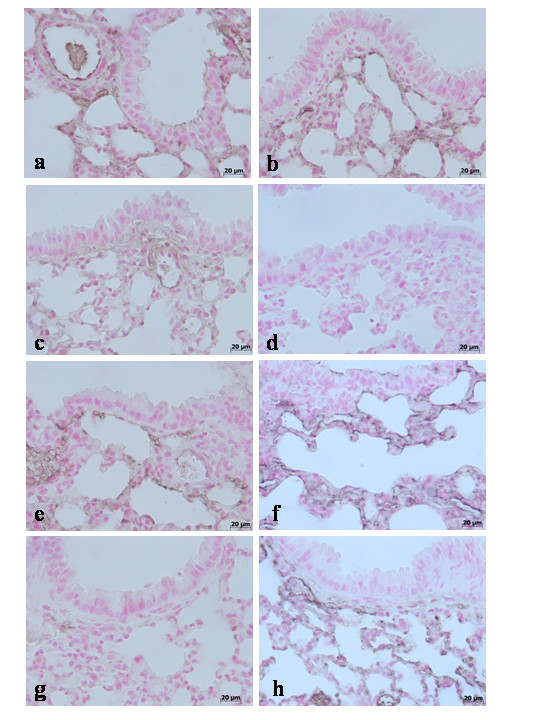
Immunohistochemical localization of Claudin-2 in the lung. In lung tissue sections collected at 24 hours from sham WT mice (a) and from sham TNF-αR1KO mice (b), Claudin-2 were uniformly and continuously distributed along the alveolar epithelium and the vascular endothelium. On the contrary, a significant disruption of immunohistochemical localization signal for Claudin-2 was observed in the lung tissues sections of carrageenan-treated WT mice at 4 h (c) and at 24 hours (d) after carrageenan. In lungs of carrageenan-treated TNF-αR1KO mice was found less irregular distribution pattern of Claudin-2 at 4 h (e) and at 24 hours (f) after carrageenan. Similarly, the treatment of WT mice with Etanercept (5 mg/kg administered s.c. 2 h prior carrageenan) were able to prevent carrageenan-induced distribution alteration of Claudin-2 at 4 h (g) and at 24 hours (h) after carrageenan. Figure is representative of at least 3 experiments performed on different experimental days.